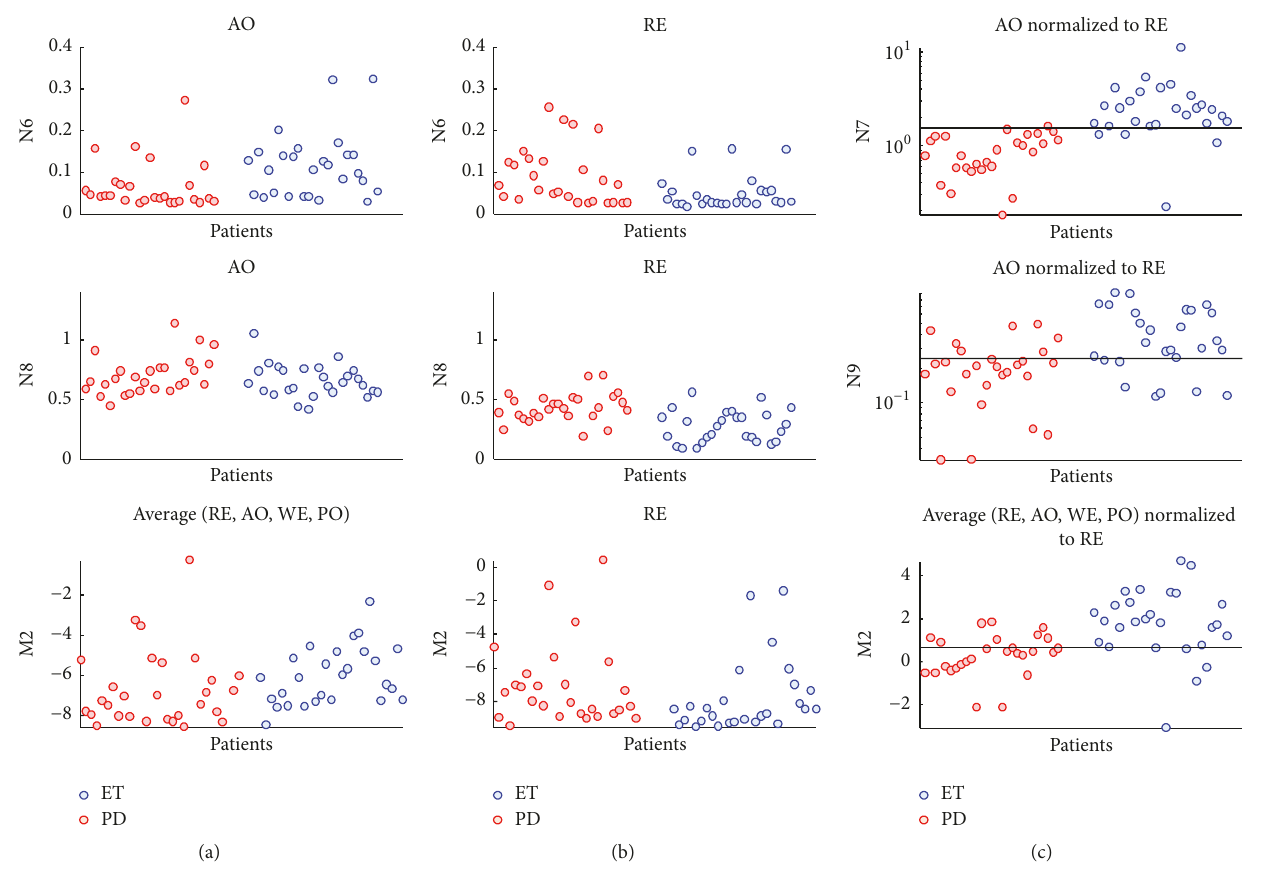
Figure 7: Values of the global tremor symmetry (N6 and N7), the coefficient of variation for pairwise motor unit synchronization (N8 and N9), and the mean log power of all the harmonics (M2) metrics in the postural (AO, WE, and PO) and rest (RE) conditions. Normalization of the metrics during postural tasks with respect to their values during the RE task significantly increased the power to discriminate between ET and PD patients (c). The black horizontal lines depict the best cut-off values as listed in Tables 1 and 2.